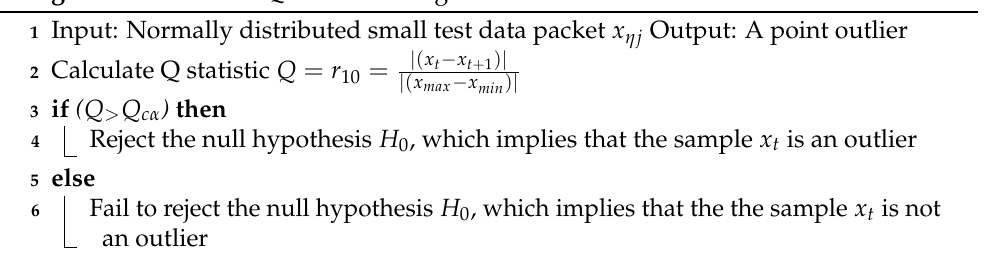
Algorithm 3: Dixon’s Q two-sided